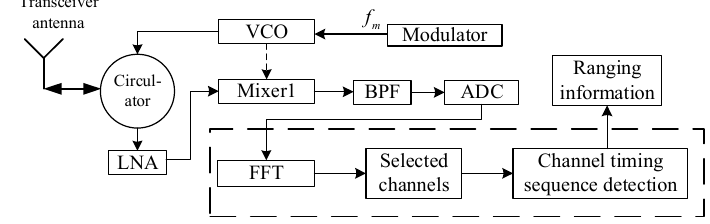
Figure 4. Block diagram of multi-harmonic timing sequence detection based on FFT (The operations in the dashed box are implemented using a digital device).